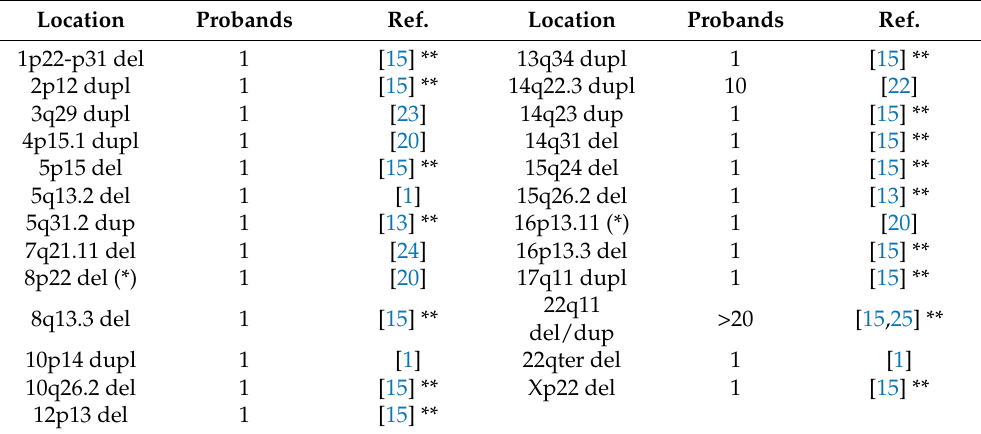
Table 2. Some chromosomal abnormalities associated with OAVS. Del, deletion; Dupl, duplication.